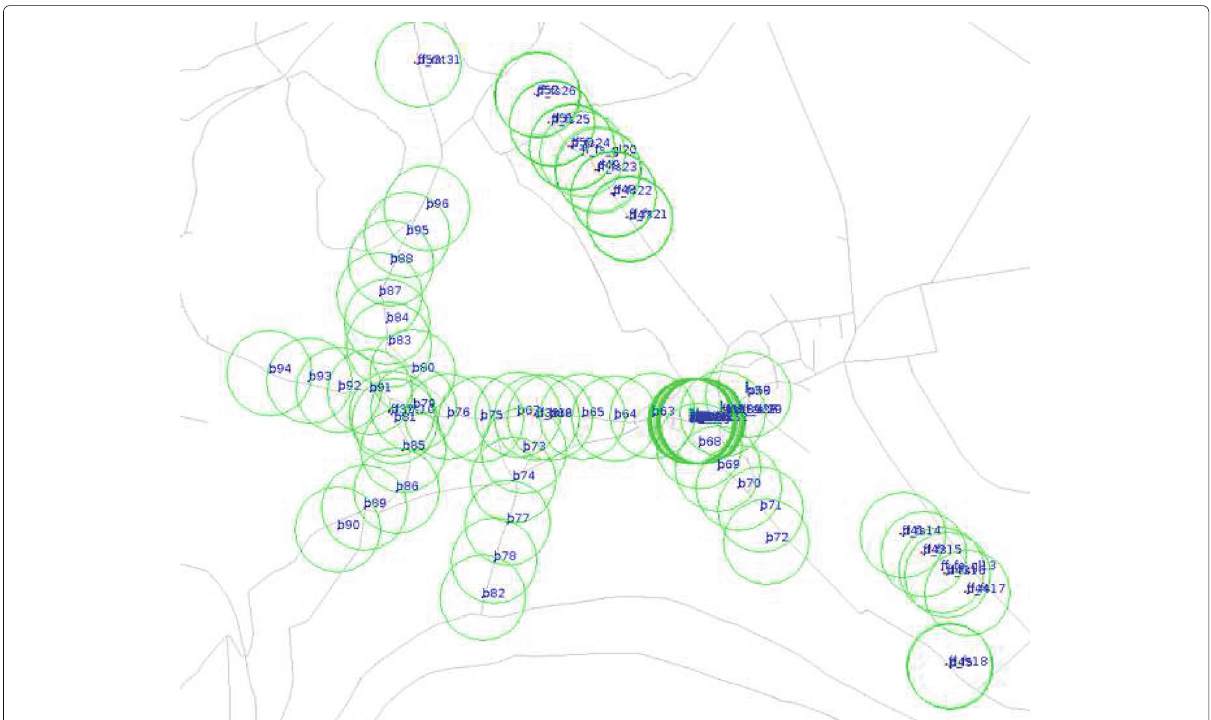
Fig. 1 Screenshot of the Search and Rescue scenario in ONE with backbone nodes deployed along the center of the